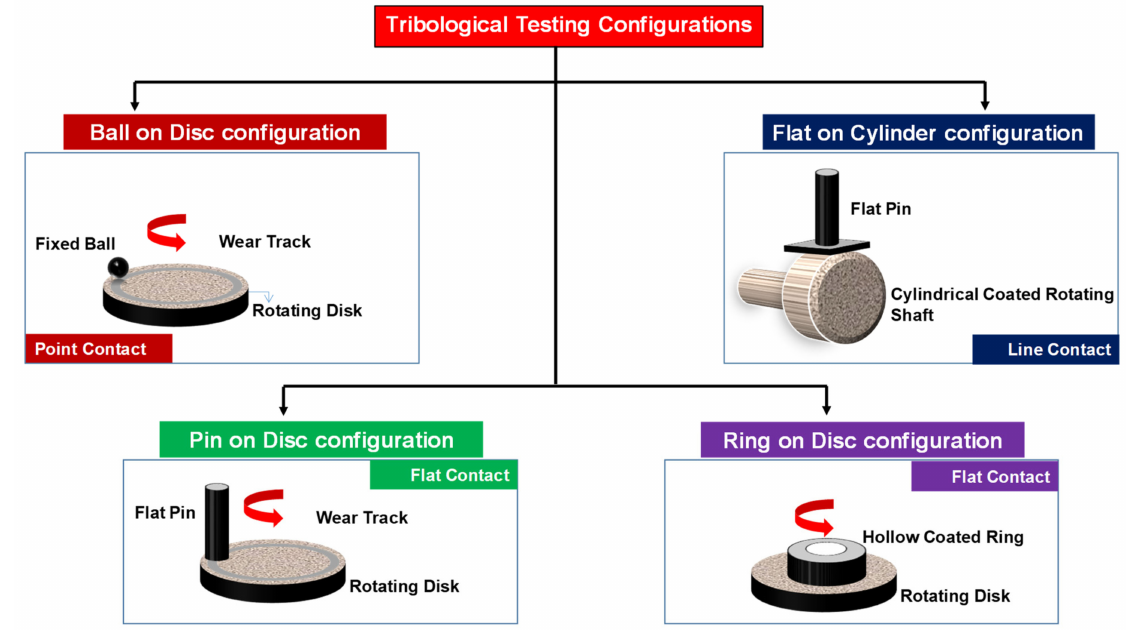
Figure 19. Different configurations used by researchers to conduct tribological characterizations of the UHMWPE nanocom- posite